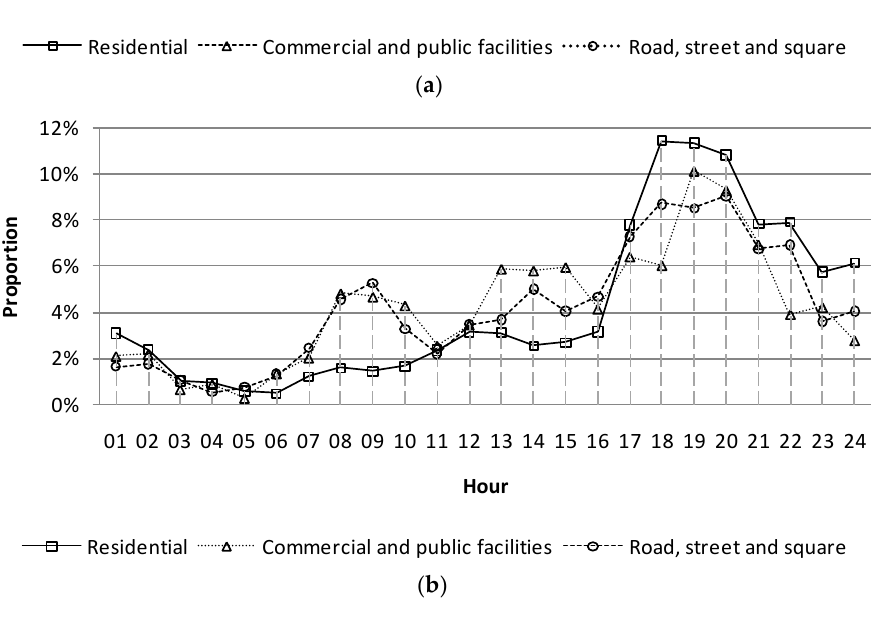
Figure 4. Three types of land use with most non-motor ( a ) and motor ( b ) vehicle thefts.